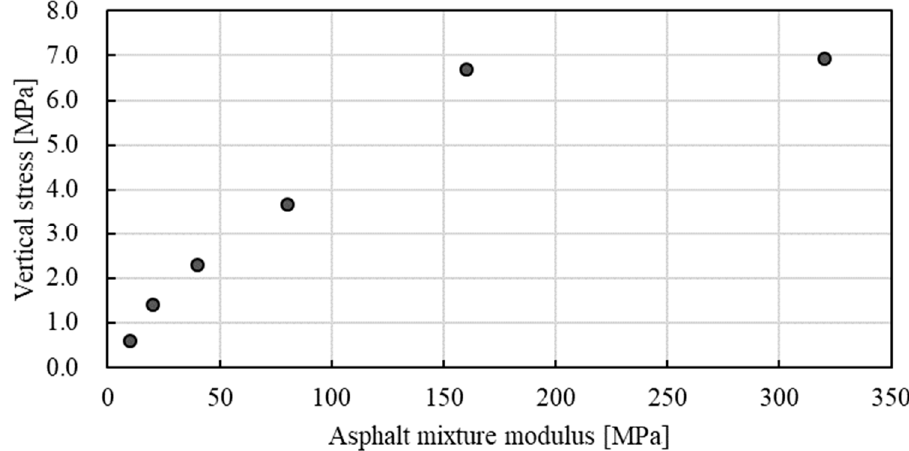
Figure 20. Effect of the asphalt mixture modulus on Marshall compaction-induced vertical stress.